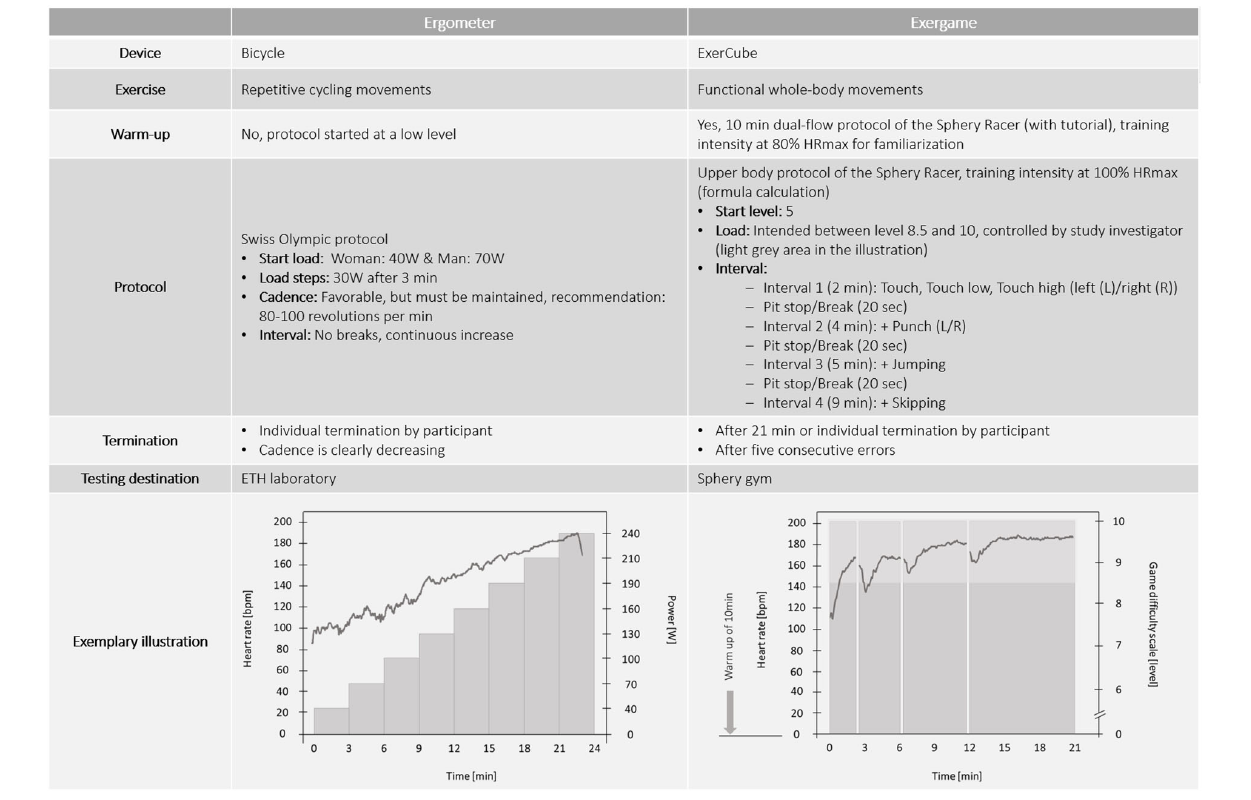
FIGURE 3 | Comparison of the different protocols to determine individual maximal heart-rate. Reference for Swiss Olympic protocol (Maier et al.,